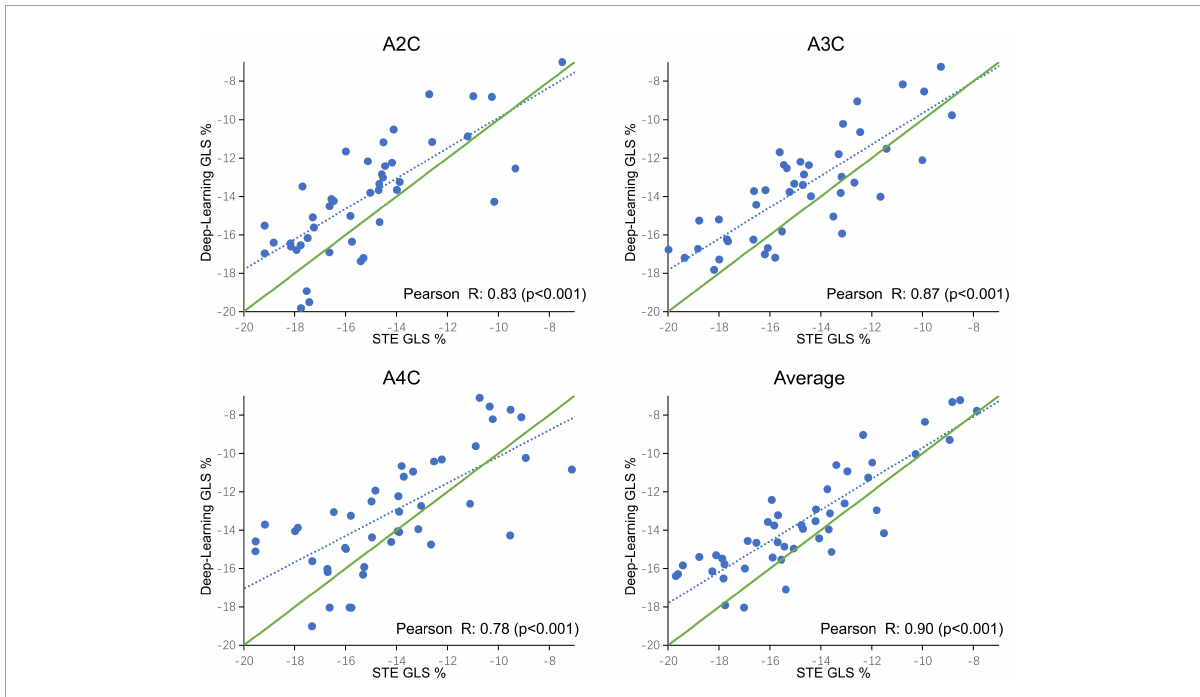
FIGURE6 Correlation plot of global longitudinal strain (GLS) estimated between STE and deep learning-based method for specific views and averaged over the three apical views. Each dot represents one examination. Blue dotted line represents the best fit line to the data by linear regression. Green solid line represents the theoretical perfect